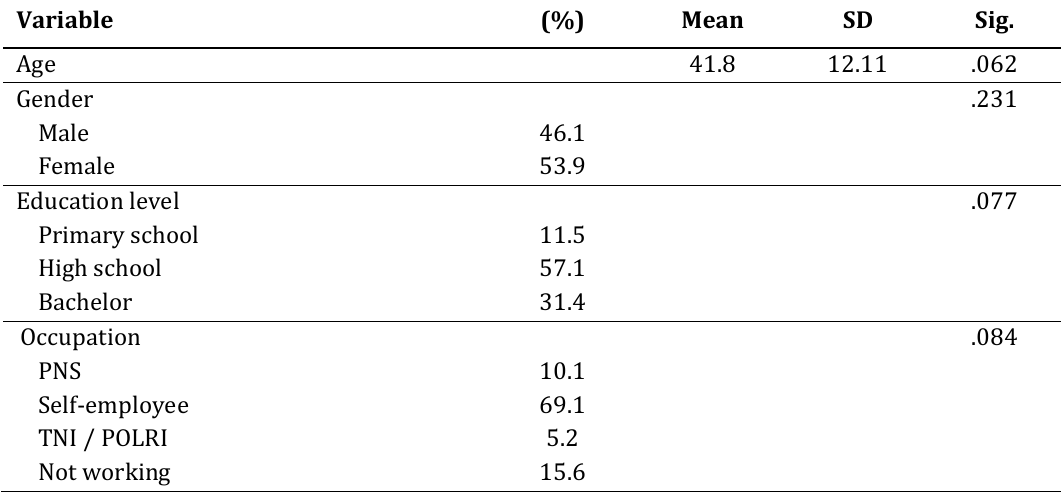
Characteristics of Respondents